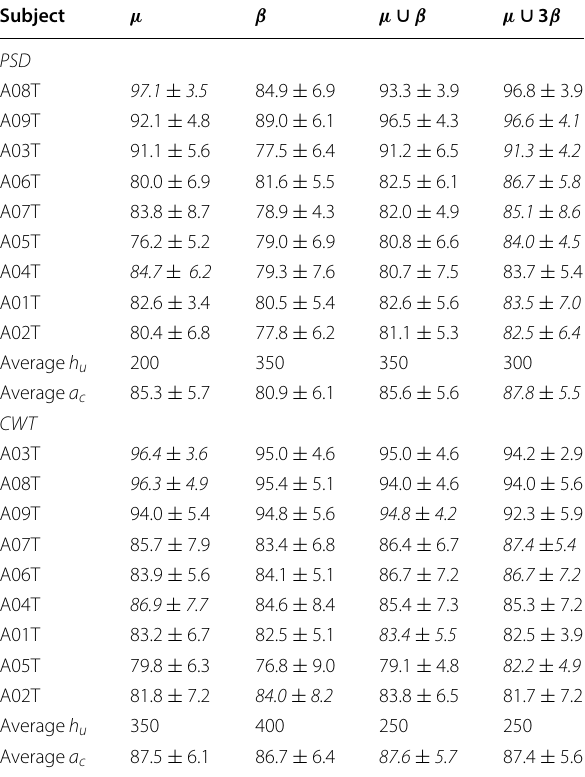
The best figure achieved by each individual is marked in italics